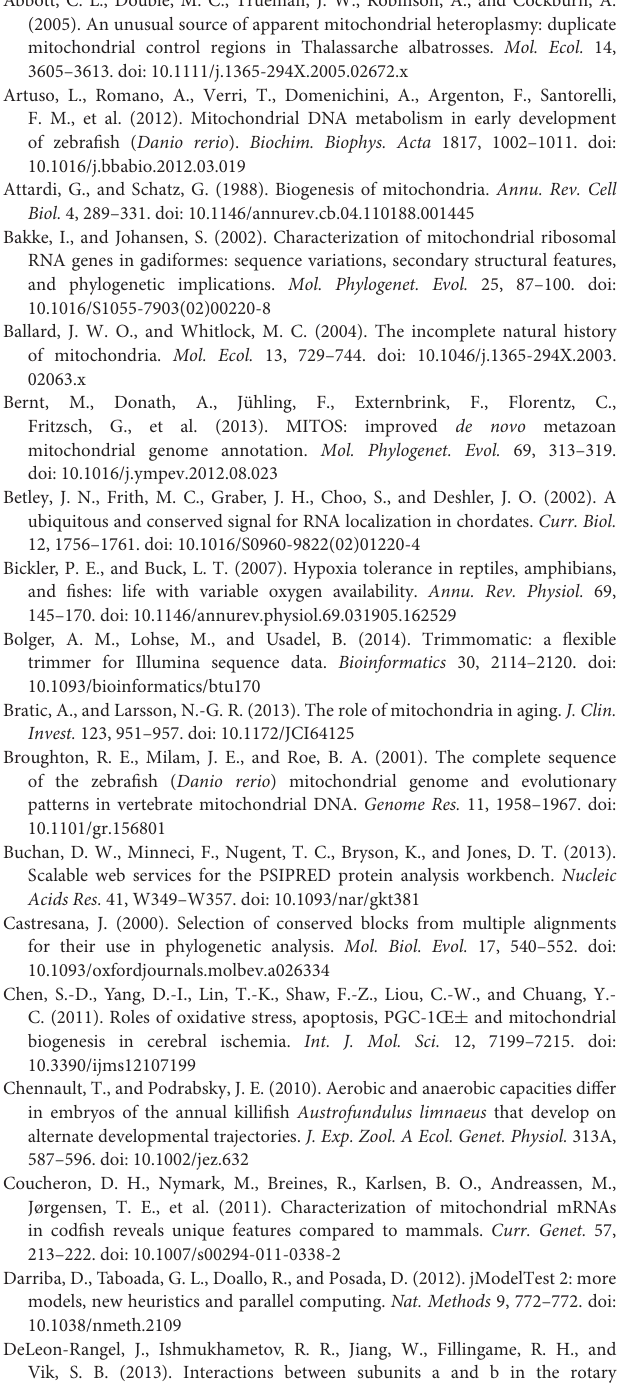
Table S5 | Top five most used codons in the A. limnaeus , A. charrua, N. furzeri , K. marmoratus , and A. panchax mtgenomes. Codon usage was determined using CAIcal. Top codons that are shared by all five species are noted in bold.